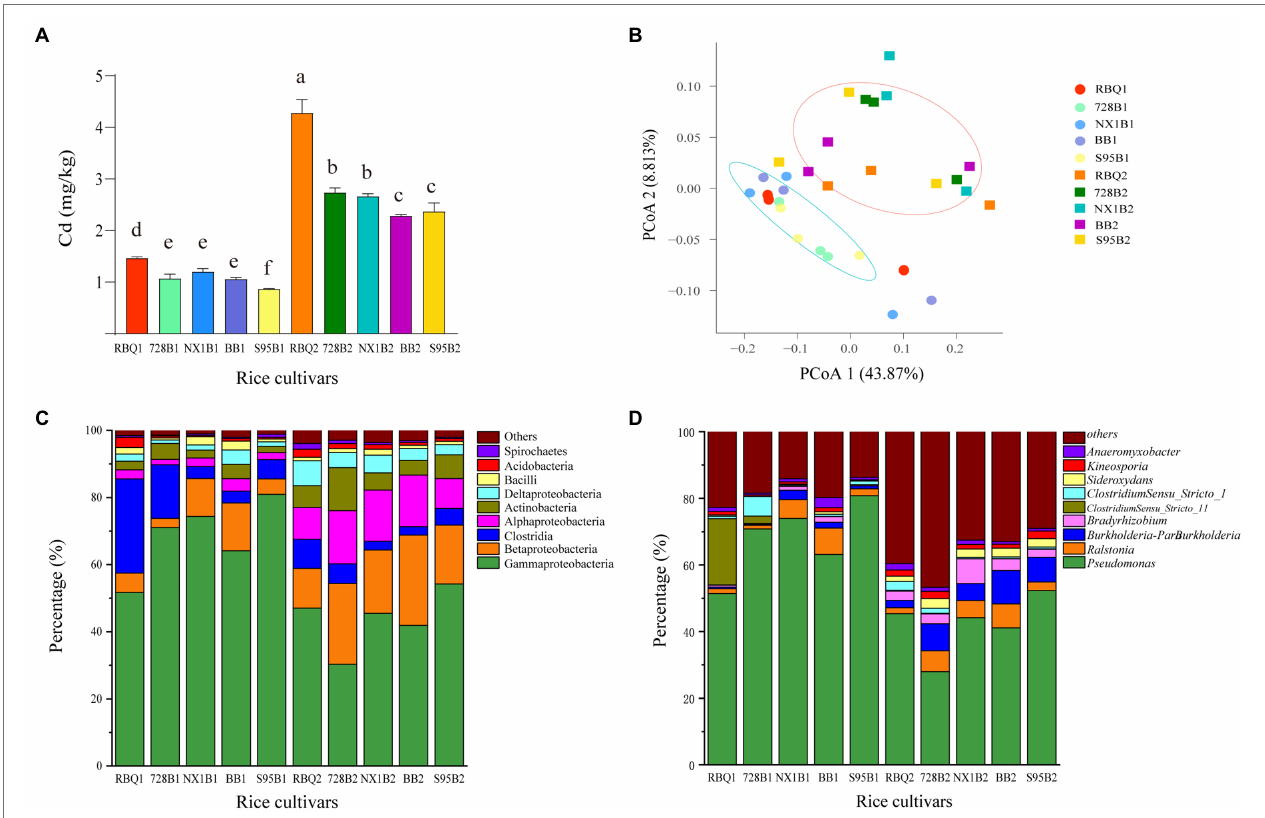
FIGURE 1 | Cd content in roots of five rice cultivars at the vegetative and reproductive stages (A) ; Principal coordinate analysis (PCoA) based on weighted UniFrac distance matrices at observed operational taxonomic unit (OTU) level (B) ; relative abundances of the dominant classes (C) and genera (D) ; hereafter, the cultivar name followed by 1 represents the vegetative stage and by 2 represents the reproductive stage. The different lowercase letters indicate significant differences among cultivars at p < 0.05.